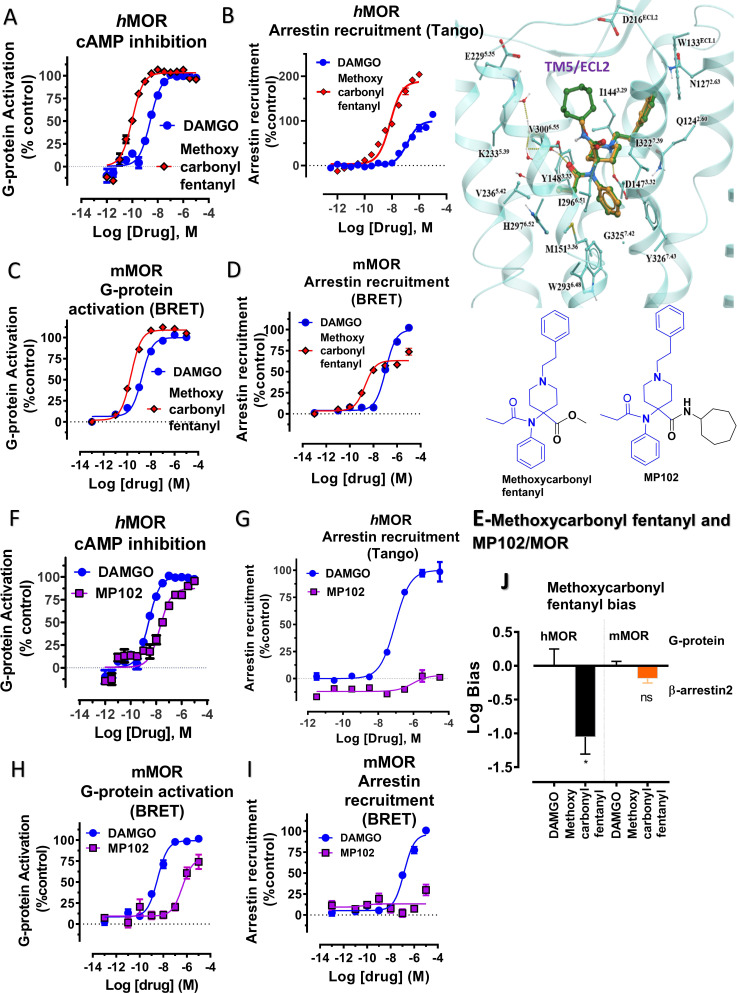
Methoxycarbonyl fentanyl amide analog MP102 targeting TM5 in MOR shows no arrestin recruitment compared to methoxycarbonyl fentanyl at mMOR in BRET assays.(A-B) Methoxycarbonyl fentanyl (red) is a full agonist at hMOR in cAMP (N = 3) and arrestin recruitment assays (N = 3) compared to DAMGO (blue). (C–D) Methoxycarbonyl fentanyl (red) is a full agonist at mMOR in BRET G protein activation (N = 4) and partial agonist in arrestin recruitment assays (N = 4) compared to DAMGO (blue). (E) Molecular docking of MP102 (green stick) engaging TM5 region and methoxycarbonyl fentanyl (yellow stick) not occupying TM5 region in hMOR. and chemical structures of methoxycarbonyl fentanyl and methoxycarbonyl fentanyl amide, MP102. (F-G) MP102 (purple) is a full agonist at mMOR in cAMP assays (N = 3) and shows no arrestin recruitment assays (N = 3) compared to DAMGO (blue). (H–I) Similarly, MP102 (purple) is a partial agonist at mMOR in BRET G protein activation assays (N = 3) and shows no arrestin recruitment assays (N = 6) compared to DAMGO (blue). (J) Bias plots for DAMGO and methoxycarbonyl fentanyl at hMOR and mMOR. Methoxycarbonyl fentanyl is arrestin biased at hMOR and shows no preference for any pathway at mMOR. Data are mean± SEM from N = 3 replicates and is analyzed using unpaired t-test with Welch’s correction,***p=0.0001. See Appendix 1—tables 7– eight for values, and Appendix 1—table 10 and Appendix 1—table 11 for bias calculations.